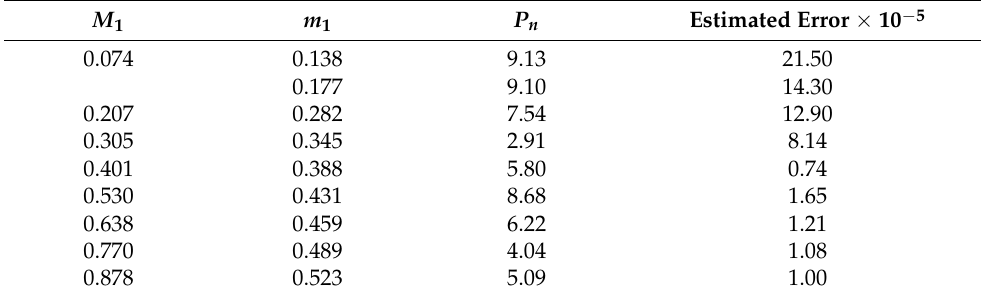
Table 3. The input data for low conversion and r 1 = 0.02 and r 2 = 0.40 (LC1).